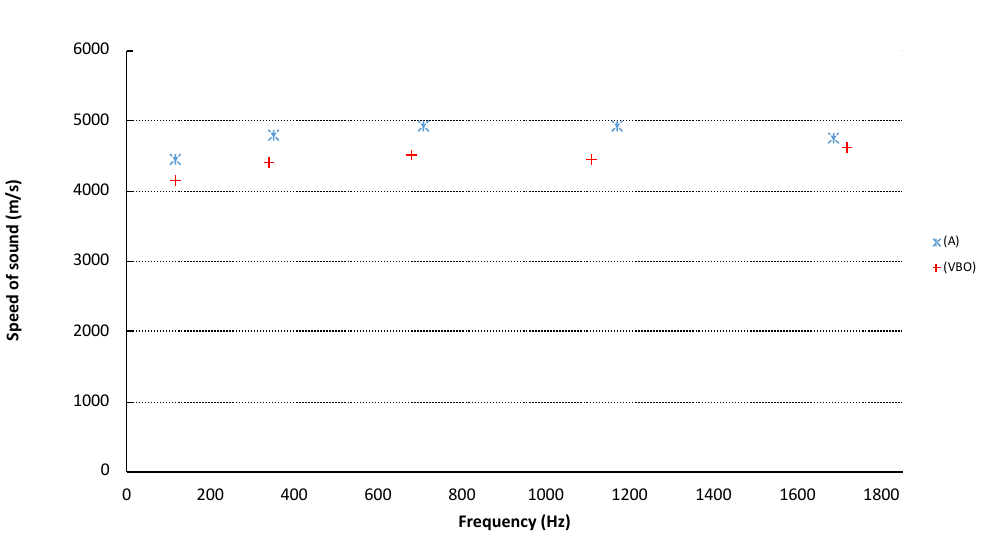
Figure 10. Average sound speed ( c ) at different frequencies, for CFRE prepregs, processed by A (autoclave) and VBO (vacuum bag-only).